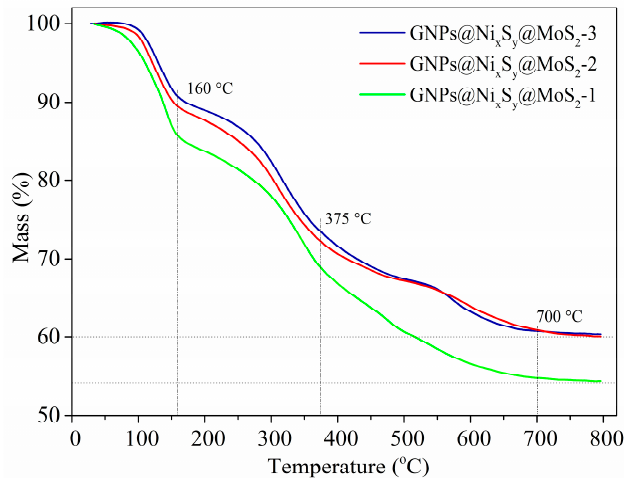
Figure 6. TG curves of as-prepared GNPs@Ni x S y @MoS 2 composites in air atmosphere.